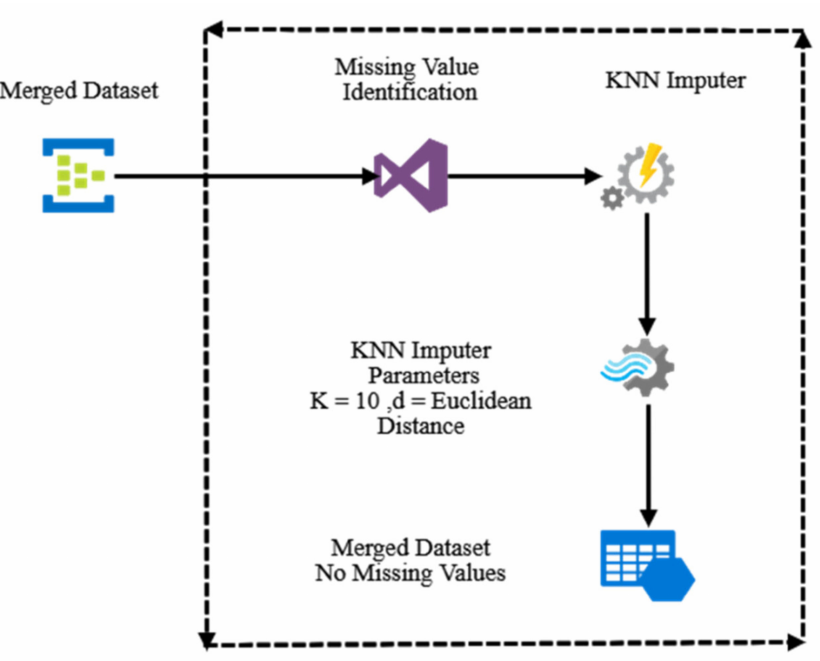
Figure 3. KNN impute